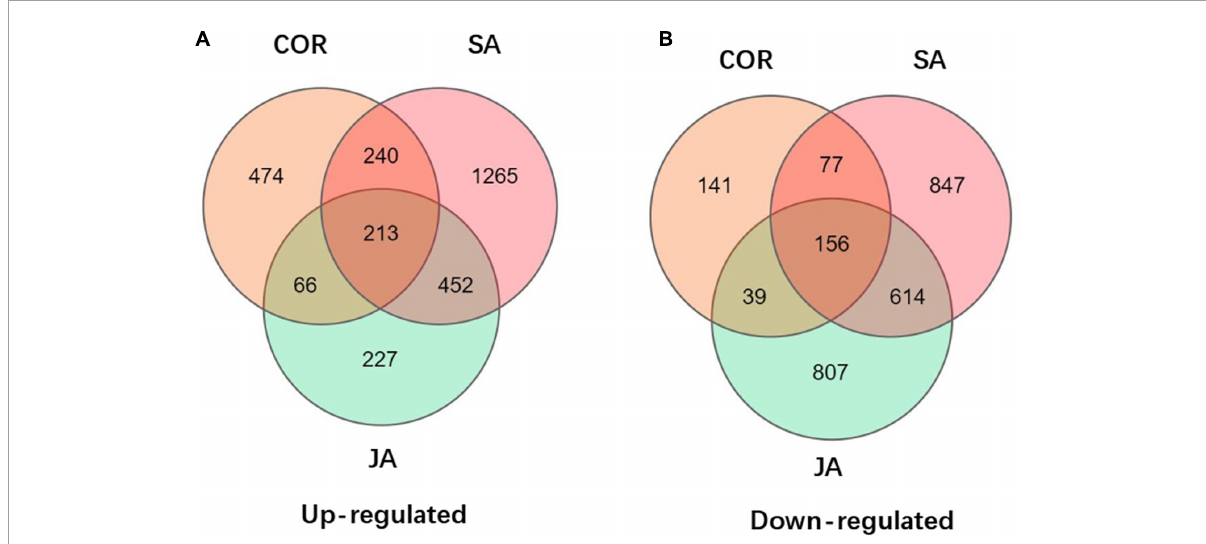
FIGURE5 Venn diagrams displays the distribution of up-regulated and down-regulated differentially expressed genes (DEGs) upon coronatine (COR), salicylic acid (SA), and jasmonate acid (JA) treatments followed by tomato yellow leaf curl virus (TYLCV) invasion. (A) Up-regulated of DEGs by JA, SA, and COR treatments followed by TYLCV invasion. (B) Down-regulated of DEGs by JA, SA, and COR treatments followed by TYLCV invasion.